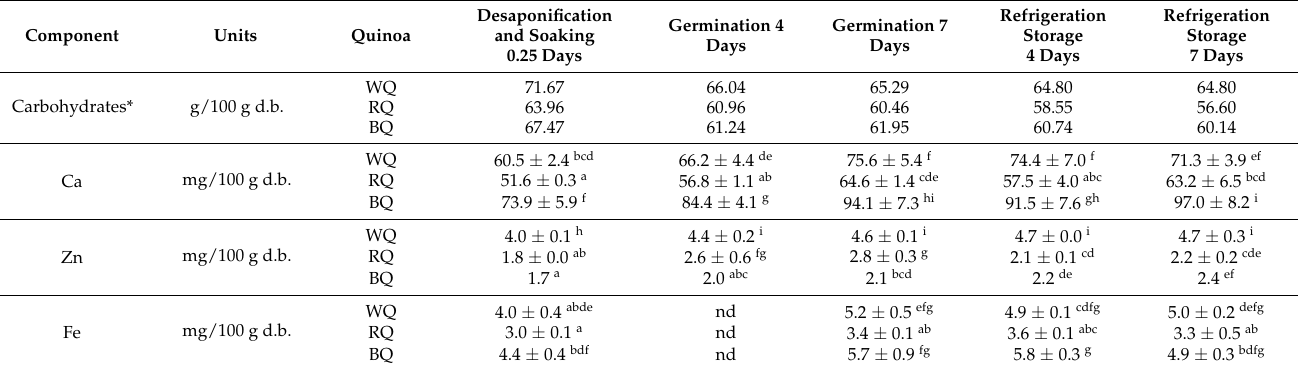
Figure 4. Lipid content variation for white (WQ), red (RQ), and black (BQ) quinoa during soaking (0.25 days), germination (4 and 7 days at 20 ◦ C and 100% RH), and refrigerated storage (11 and 14 days at 4 ◦ C and 75% RH). Error bars indicate standard deviation ( n = 3). Results with different letters are significantly different at p ≤ 0.05. Table 2. Carbohydrate and mineral content variation for white (WQ), red (RQ), and black (BQ) quinoa during soaking (0.25 days), germination (4 and 7 days at 20 ◦ C and 100% RH), and refrigerated storage (11 and 14 days at 4 ◦ C and 75%